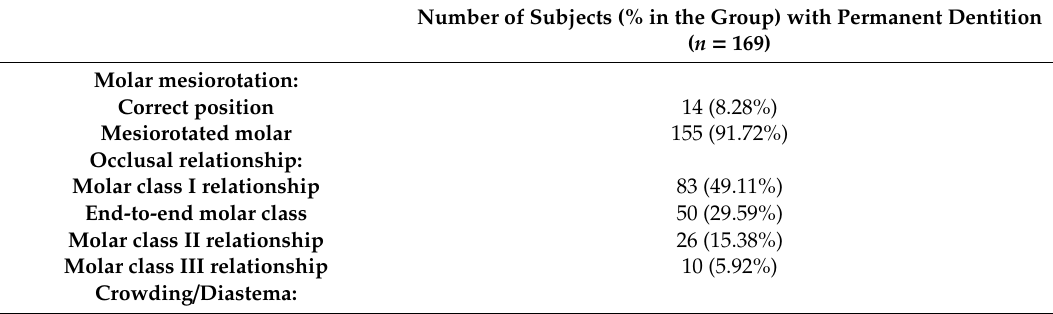
Table 2. Descriptive statistic (subject with permanent dentition) ( n =